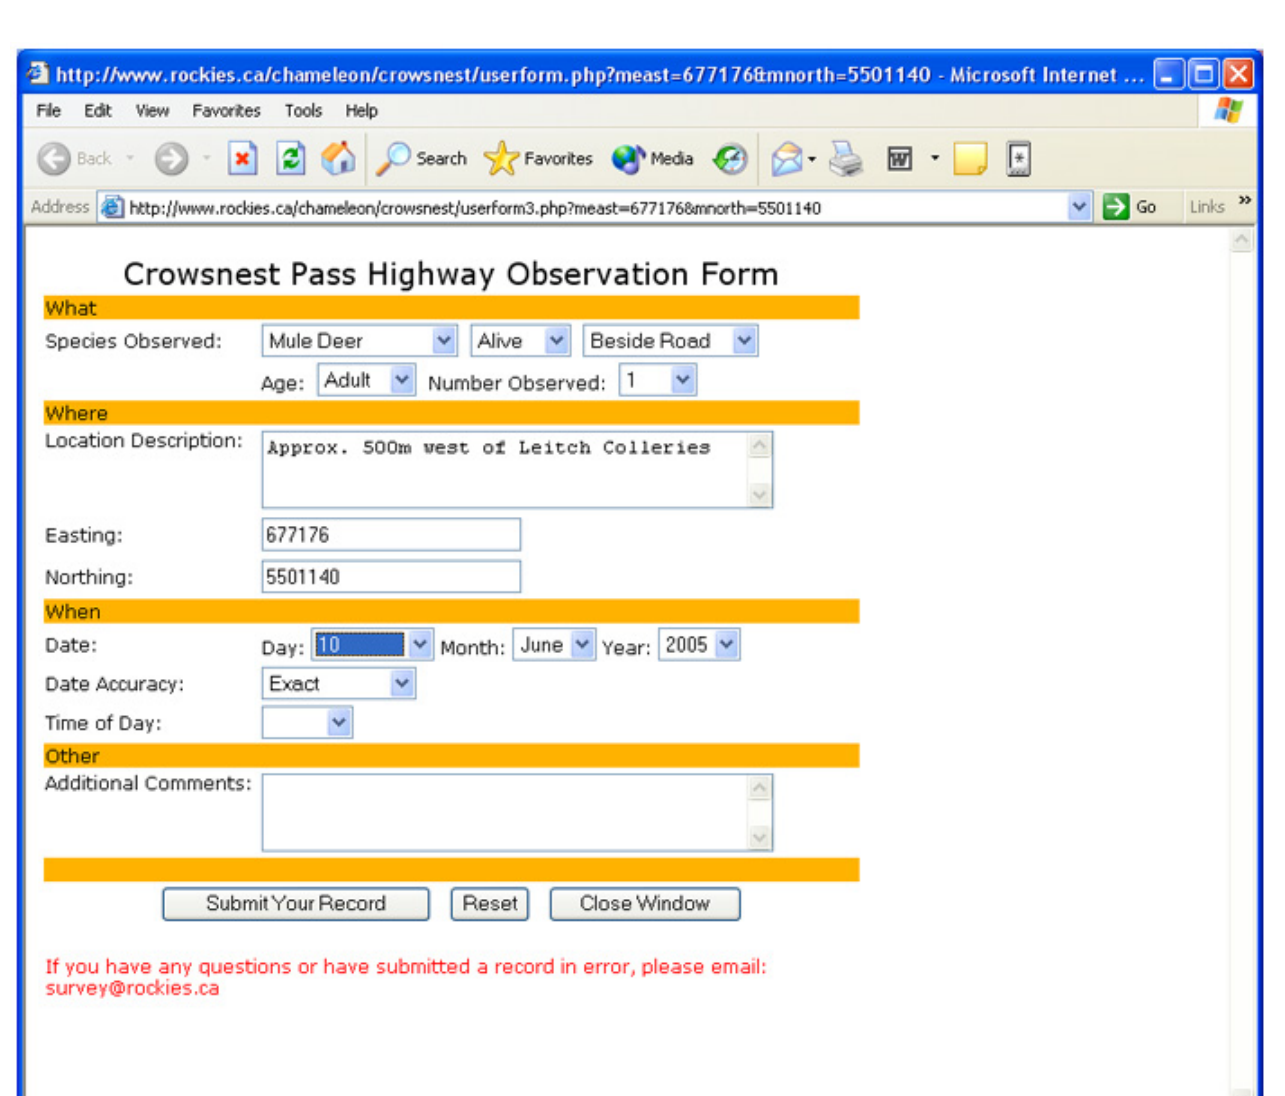
Fig. 3. Road Watch wildlife observation